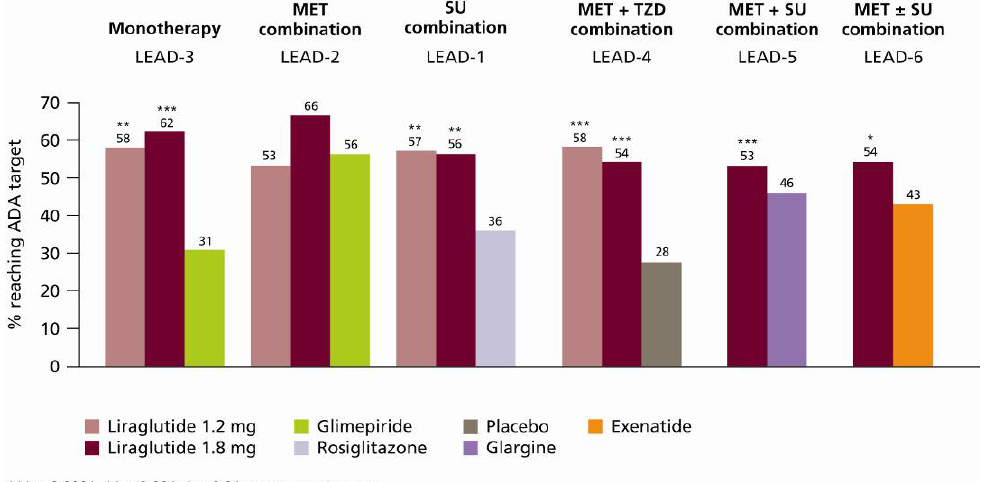
<7.0% in the LEAD-1–6 1c